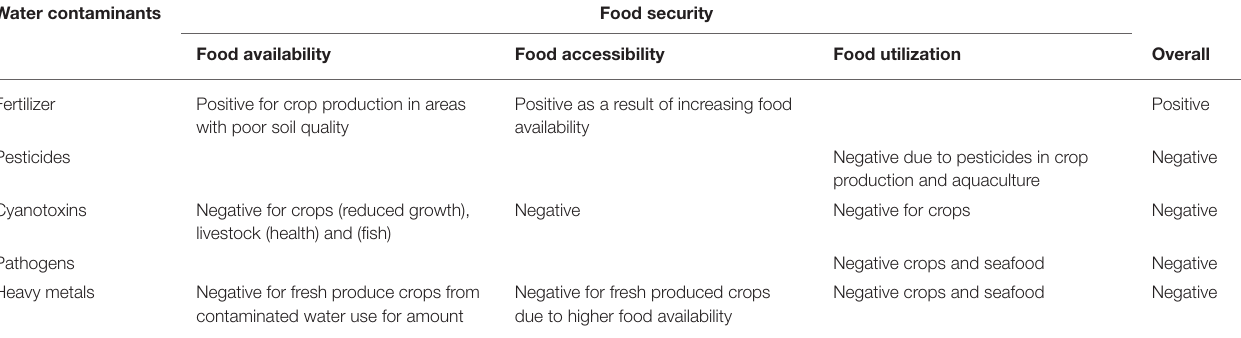
TABLE 5 | . Impacts of water contaminants on food security and aspects of food availability, food affordability and food utilization.